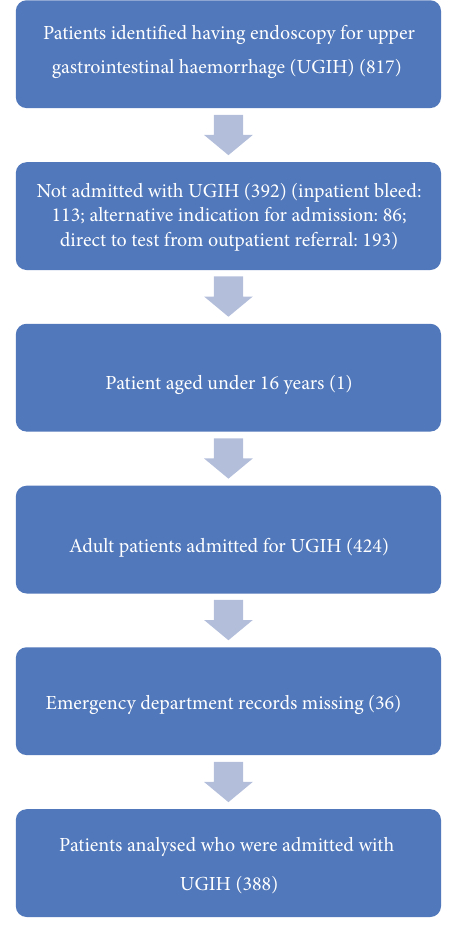
Figure 1: Flow chart demonstrating identification of patients rel- evant to this study, that is, adult patients admitted with a primary diagnosis of upper gastrointestinal haemorrhage.